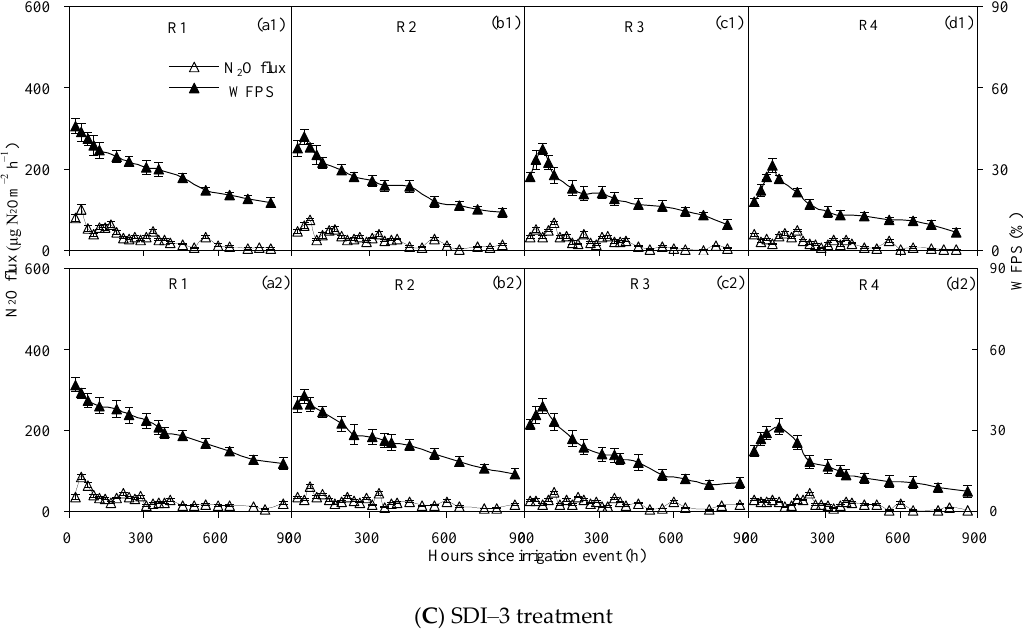
Figure 7. N 2 O emission fluxes in different sub-regions ( A – C ) from SDI treatments after the first irrigation ( a1 – d1 ) and the second irrigation ( a2 – d2 ).